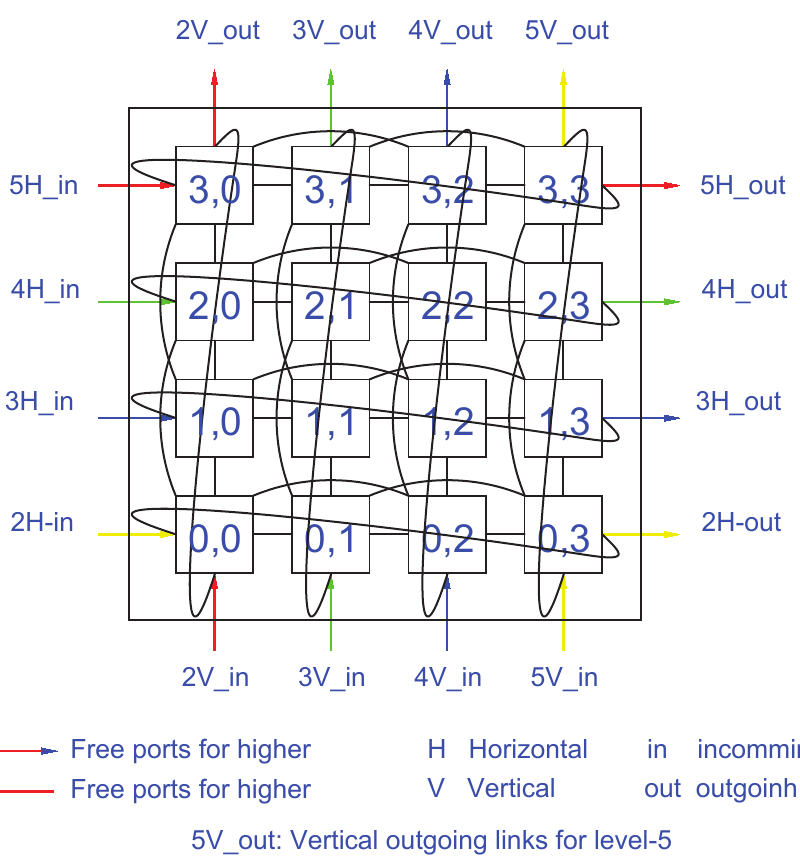
Figure 1. A 4 × 4 basic module of a TFBN as a flattened butterfly